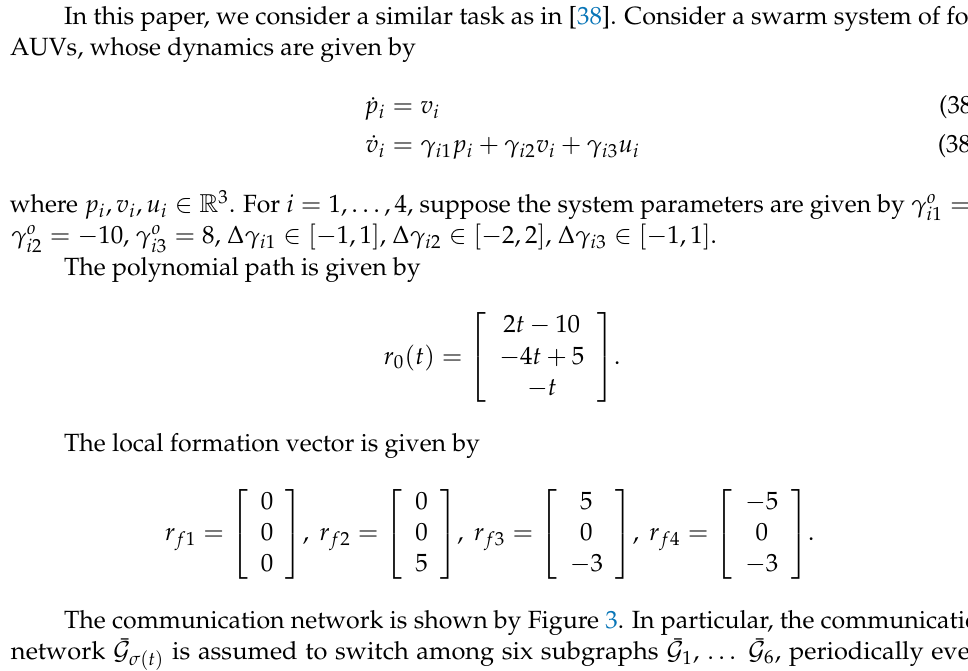
Figure 2. AUV fleet cruises in the ocean in a static triangular formation while following the reference trajectory of a straight